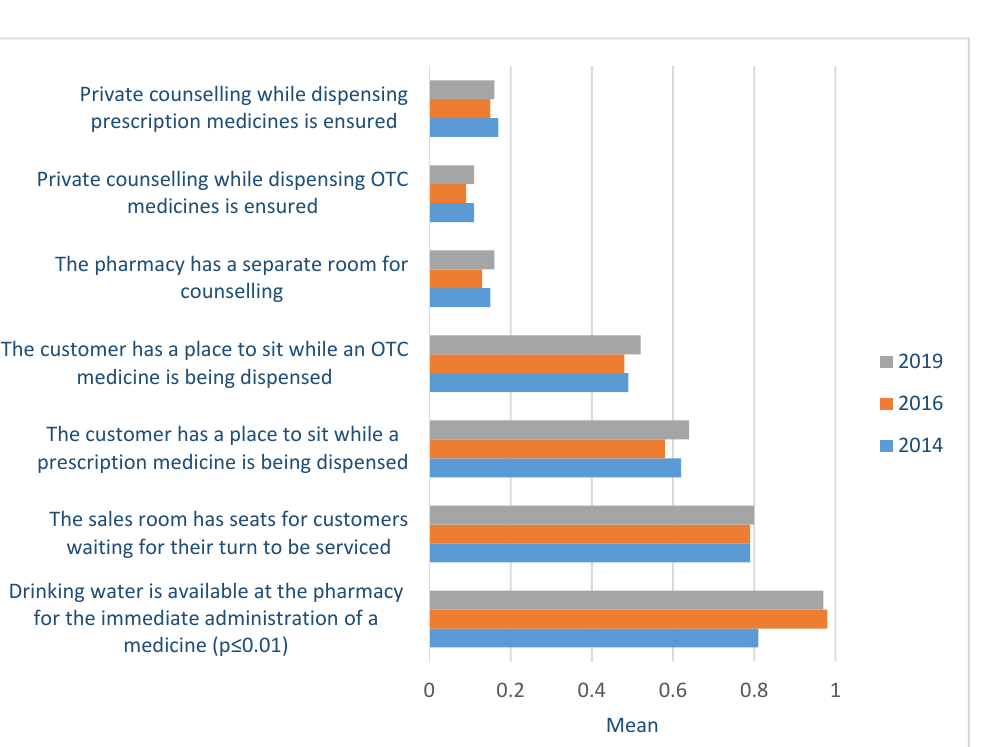
Figure 3. Provision of extended services based on evaluating the Community Pharmacy Service Quality Guideline (two-point scale) in 2014-19.